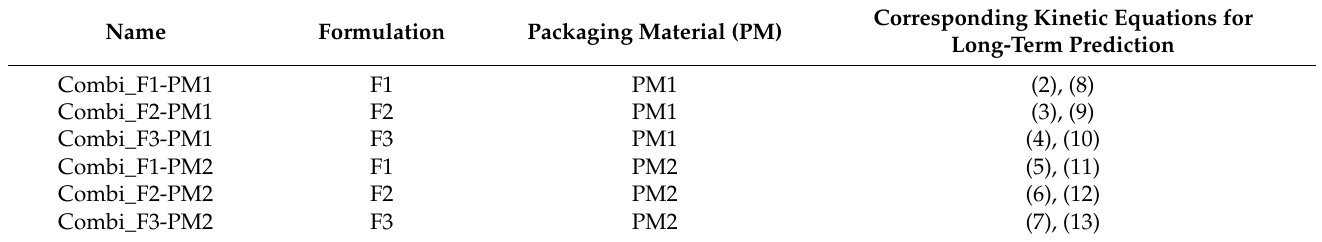
Table 3. Combinations of three different peptide formulations and two different packaging materials that were used for experimental and in silico assessment of accelerated and long-term stability. Details about the formulations (F1, F2, F3) and packaging materials (PM1, PM2) are provided in Tables 1 and 2.